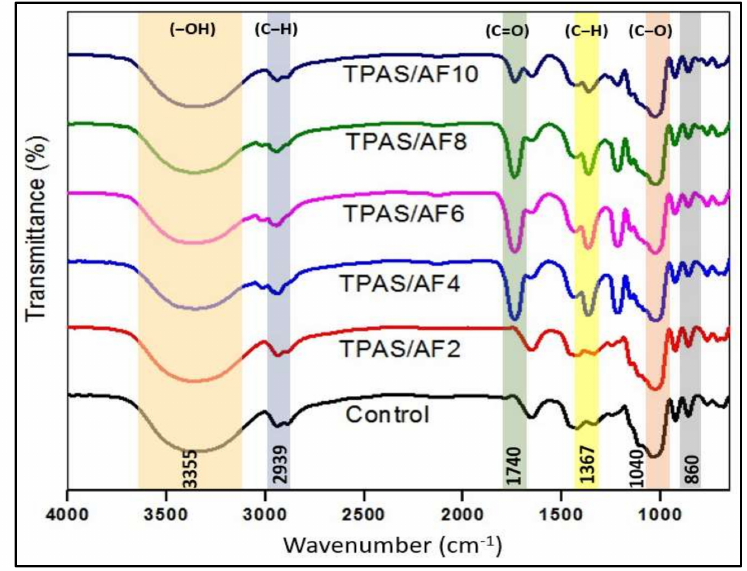
Figure 3. FTIR spectra of control and TPAS/AF composites with different fiber